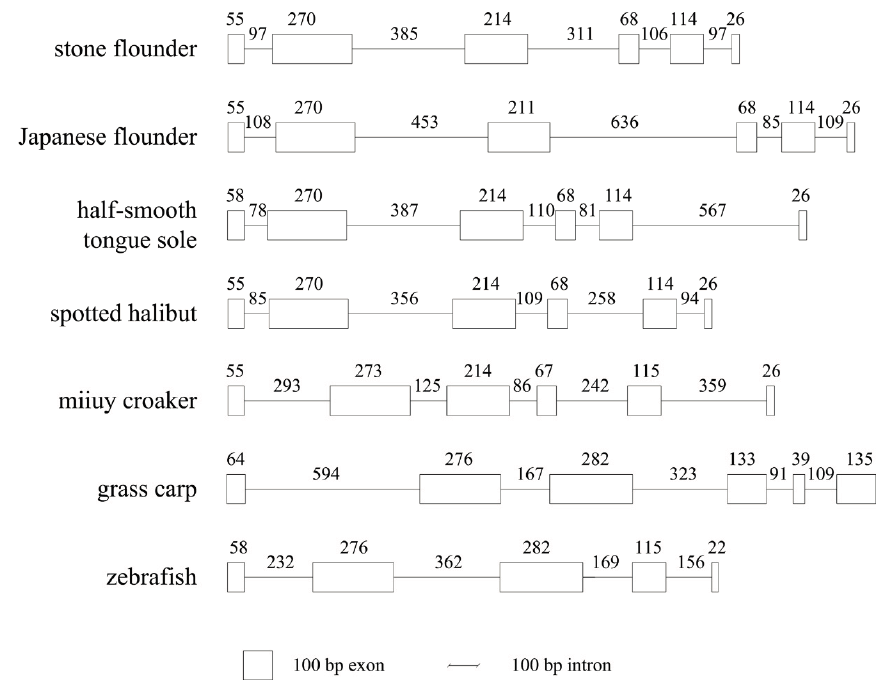
Figure 8. MHC class II B structures of seven fish species. Exons are indicated by boxes and introns are indicated by lines. The taxonomy status of these species is: stone flounder: Pleuronectidae; Japanese flounder: Paralichthyidae; half-smooth tongue sole: Cynoglossidae; spotted halibut: Pleuronectidae; miiuy croaker: Sciaenidae; grass carp: Cyprinidae; and zebrafish: